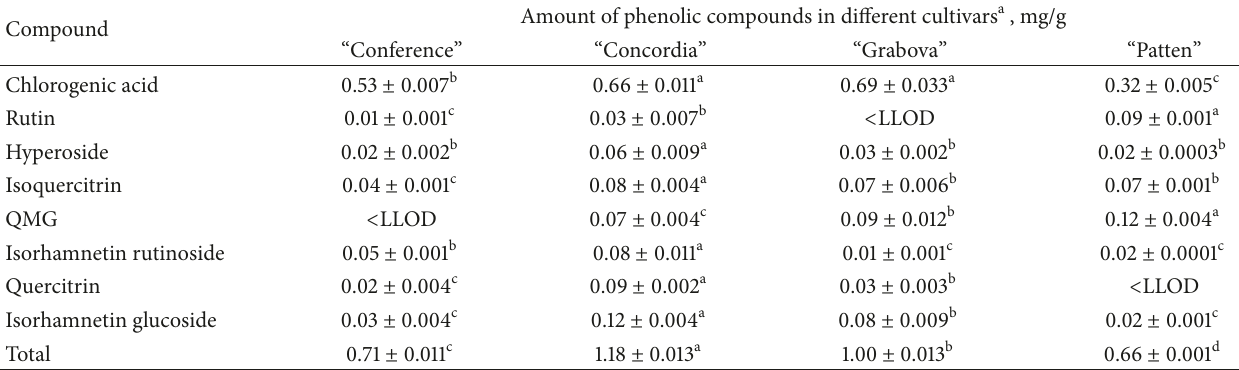
Table 3: Content of phenolic compounds in ethanol extracts obtained from pears (expressed for absolute dry lyophilisate weight). Compound